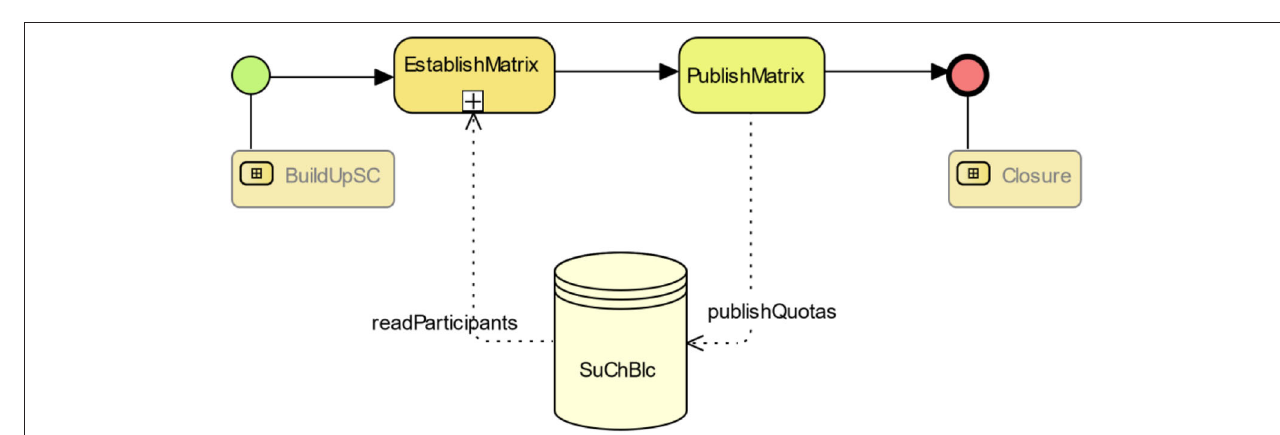
FIGURE 10 | The subprocess to compute